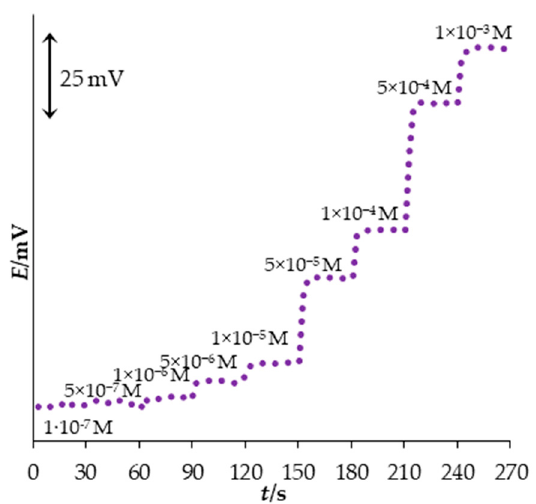
Figure 3. Dynamic response of the new PM sensor.